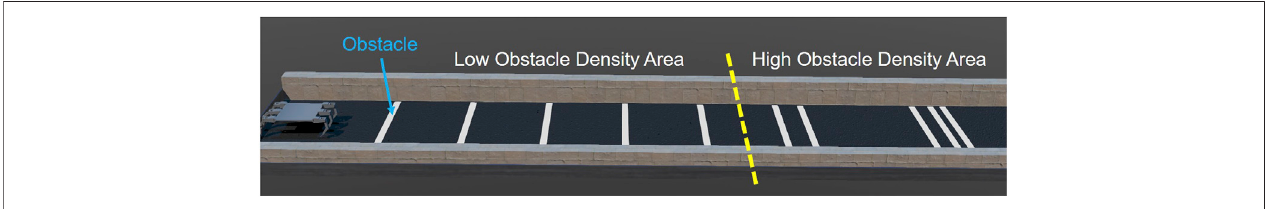
FIGURE 8 | Simulation environment set-up.